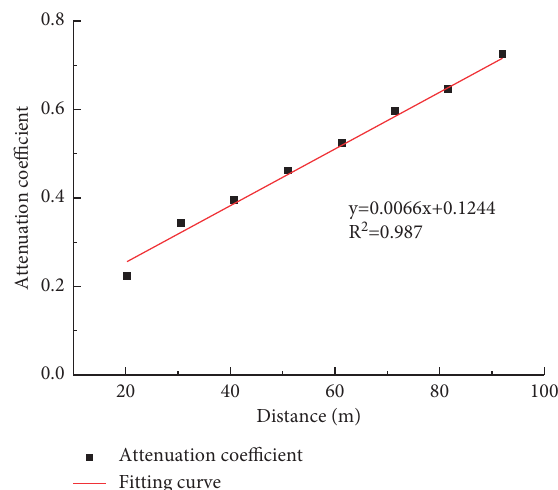
Figure 8: Attenuation coefficient varying with distance.